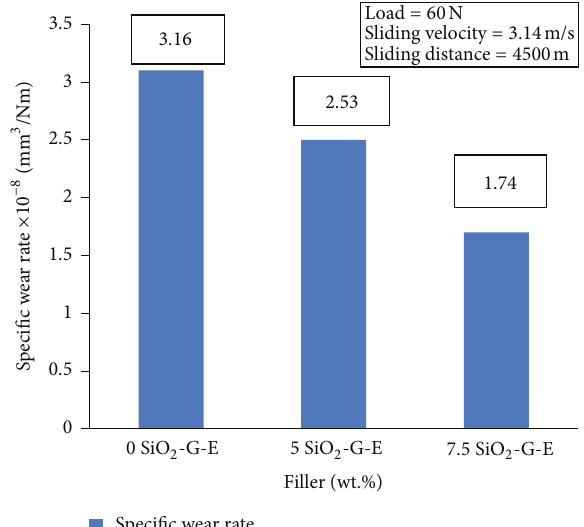
Figure 11: Specific wear rate of SiO 2 filled G-E composites.